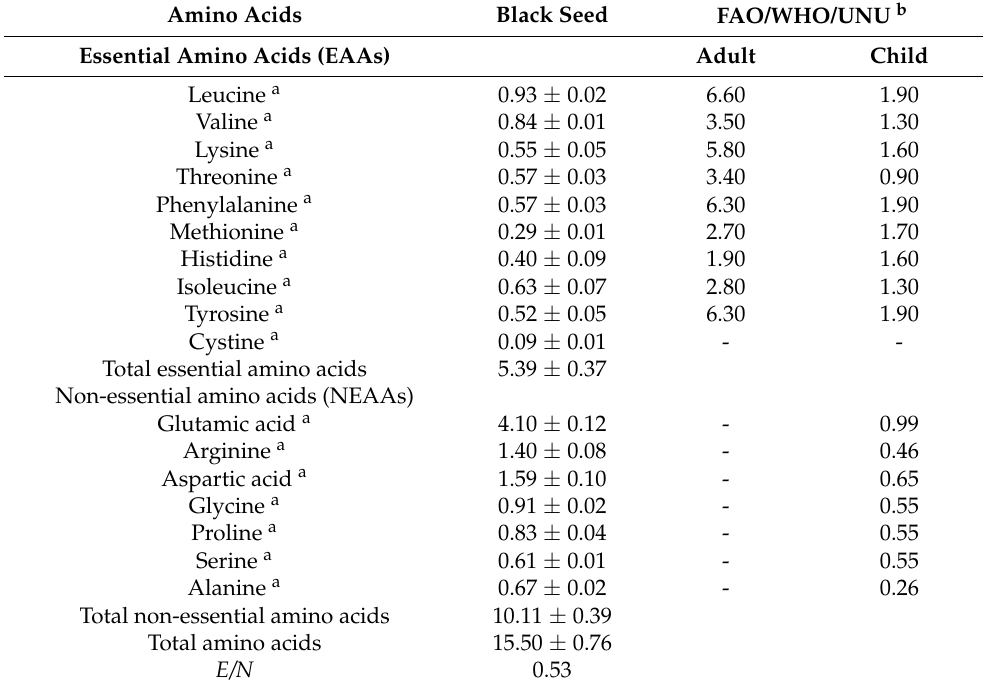
Table 2. Amino acid composition of black seeds ( Nigella sativa